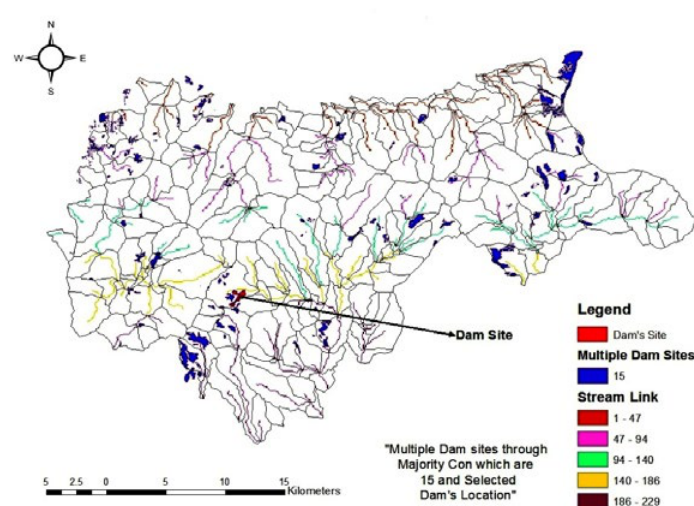
Fig. 12. Multiple dam sites and selected Fig. 12: Multiple dam sites and selected location